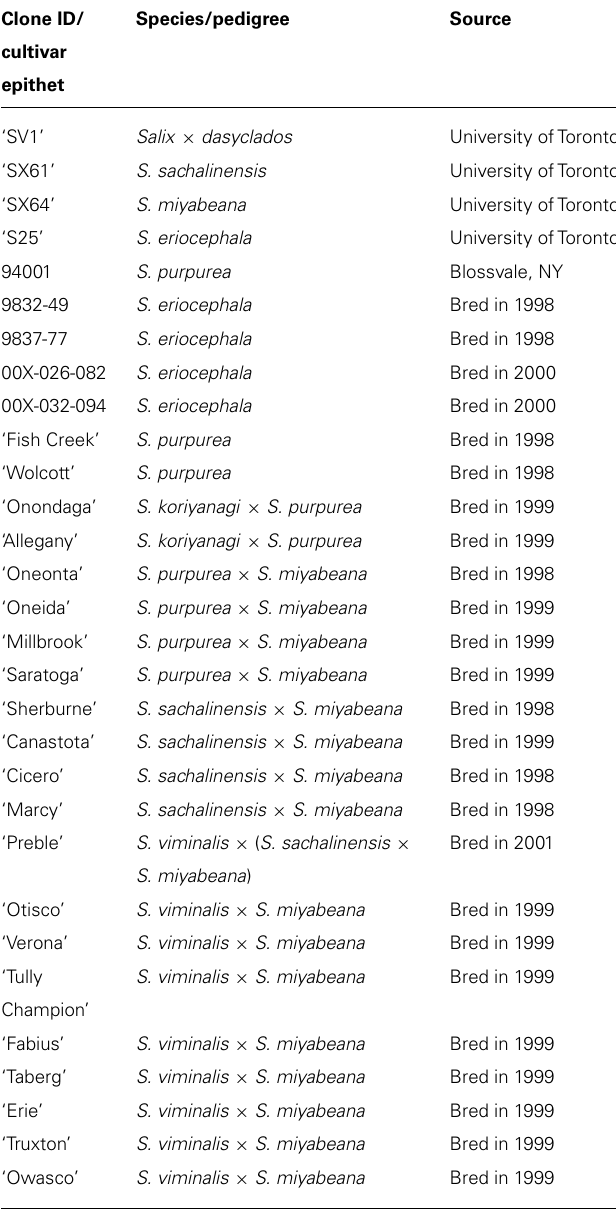
Table 1 | Shrub willow genotypes used in this study harvested from the 2006 Constableville yield